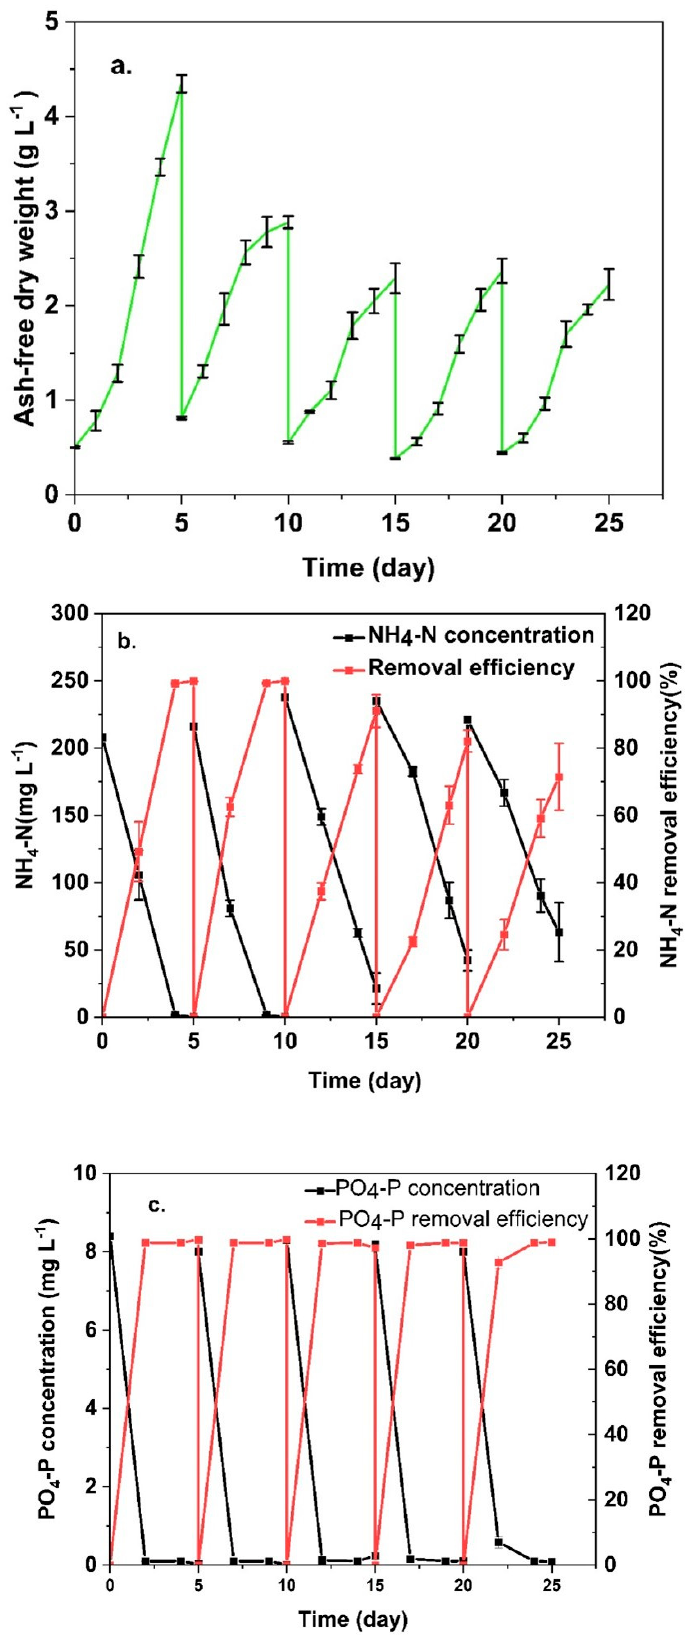
Figure 4. Growth profiles ( a ); NH 4 -N concentration and removal efficiency ( b ); PO 4 -P concentration and removal efficiency ( c ); by G. sulphuraria in 20% landfill leachate on a long-term running experi- ment.